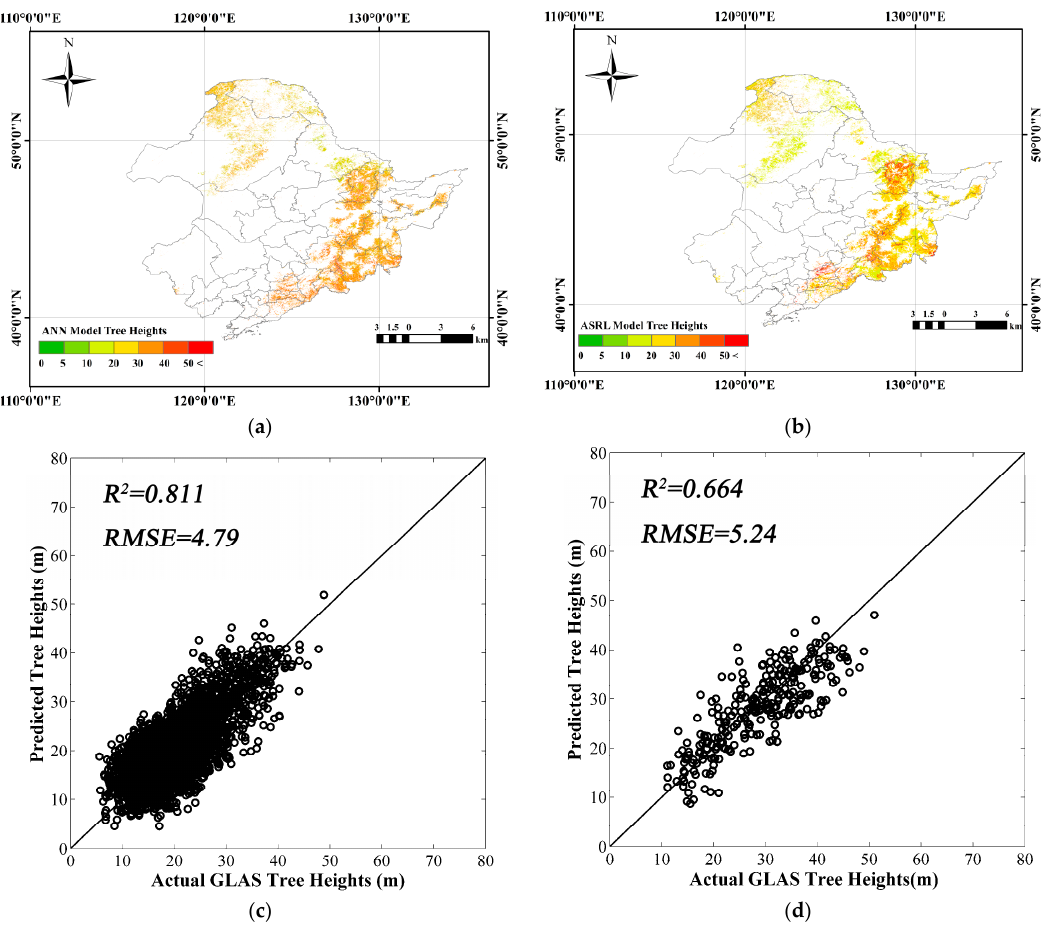
Figure 4. The forest tree heights based on ANN and ASRL methods respectively. ( a ) ANN tree heights; ( b ) ASRL tree heights; ( c ) ANN based tree heights validation; ( d ) ASRL based tree heights validation.